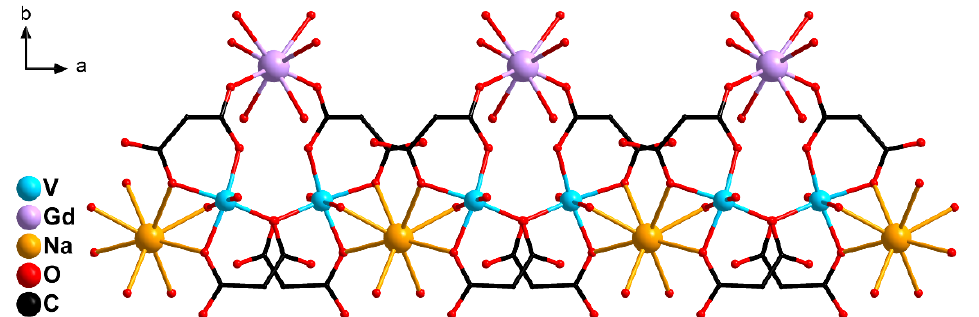
Figure 4. A fragment of 1D-polymeric chain of 1 : {GdV 2 } – units linked by Na + cations (H atoms and cyclic fragments of the carboxylate ligands are not shown).